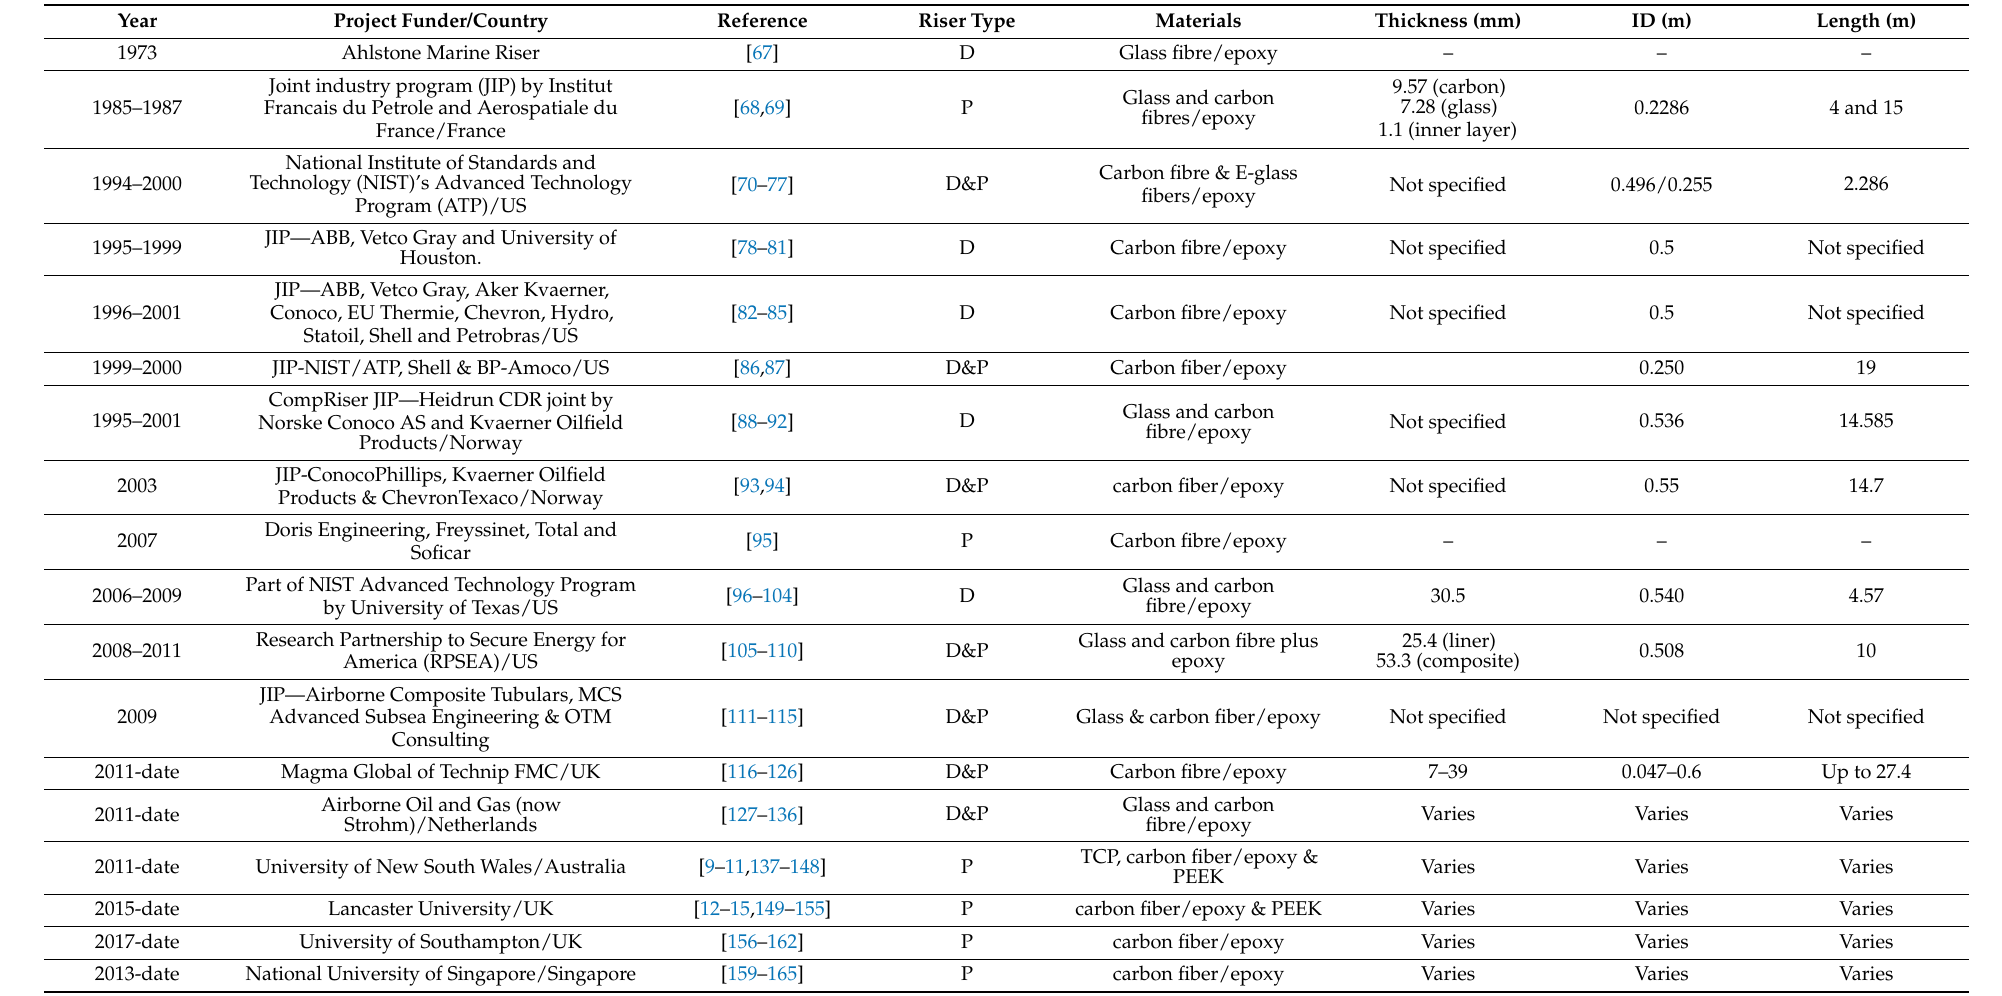
Table 1. Historical summary of previous joint industry projects on composite